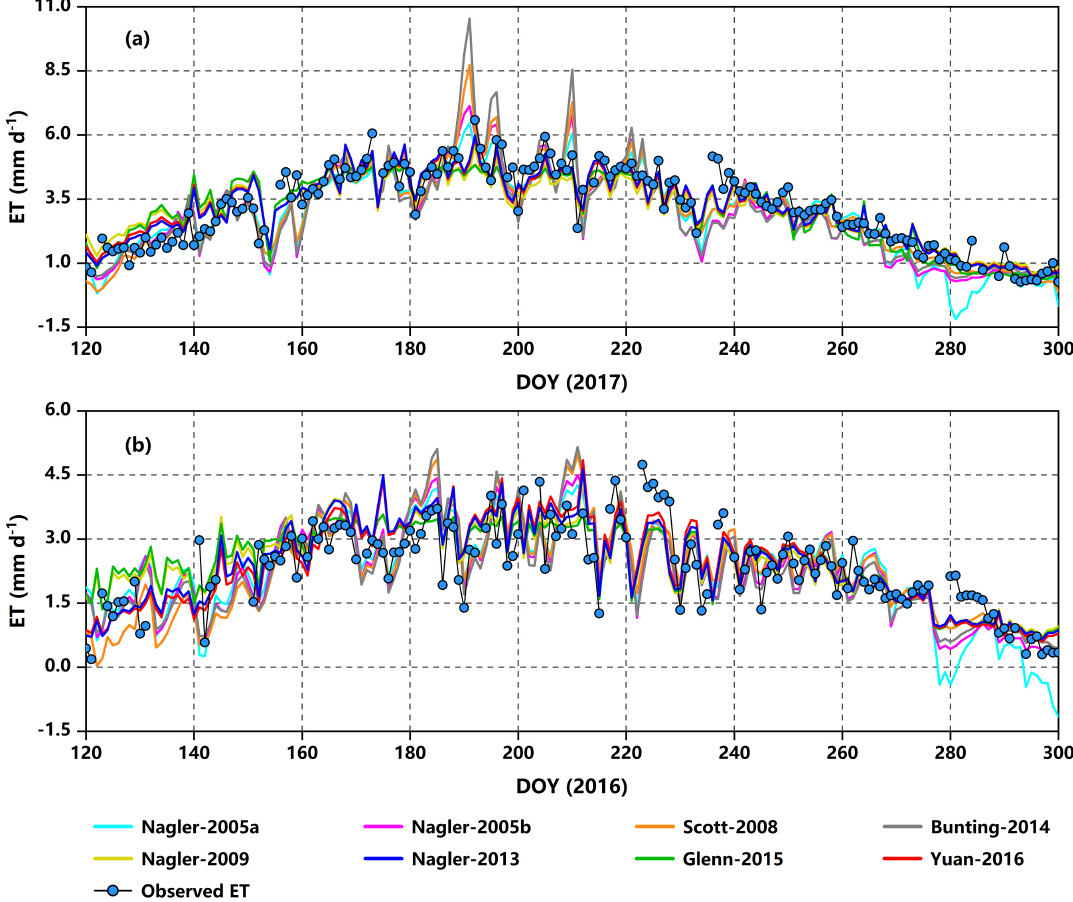
Figure 6. Daily variation process of the observed and simulated daily ET for the 2017 growing season of the Tamarix site ( a ) and the 2016 growing season of the Populus site ( b